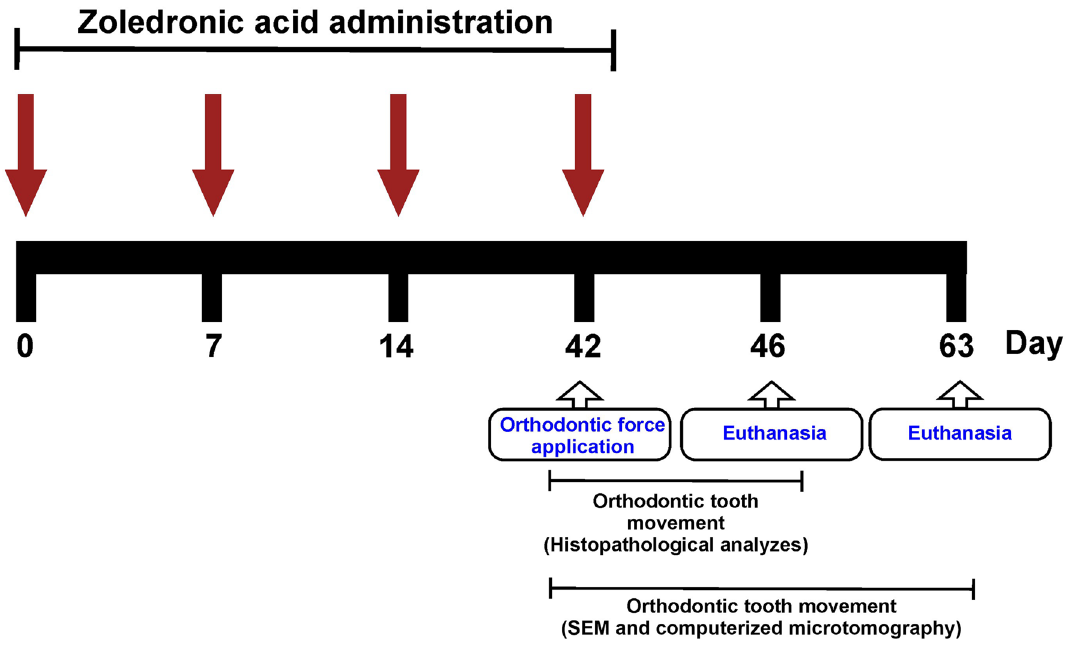
Figure 1. Schematic diagram illustrating the experimental design.